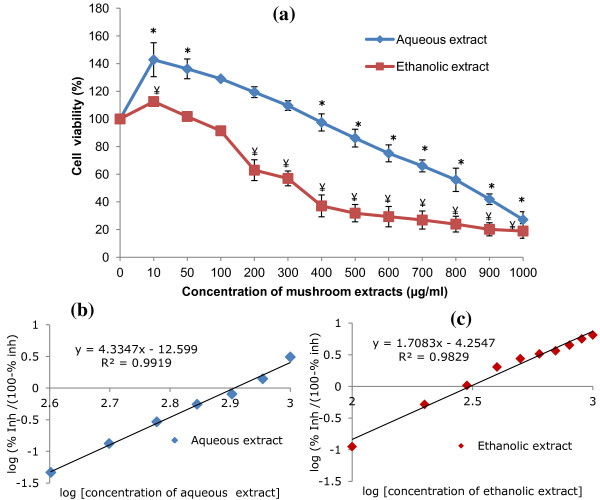
 The effects of aqueous and ethanolic extracts ofP. giganteuson PC12 cell viability. (a) Effect of aqueous extract and ethanolic extract on the cell proliferation of PC12 cells. The mean absorbance obtained using medium with cells only was designated 100%. Results shown represent the mean ± SD; n = 3. *,¥p < 0.05 for aqueous extract and ethanolic extract, respectively compared to the control 100%. (b) & (c): IC50 was obtained from the intercept on the x-axis (y = 0) of the regression line using the linear part of the percentage inhibition (% inh) curve (data not shown).